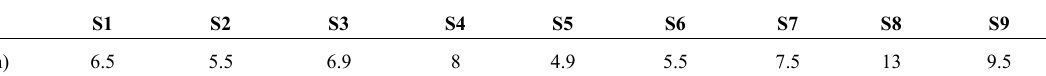
Table 1. Design parameters and flow rate of showerheads.